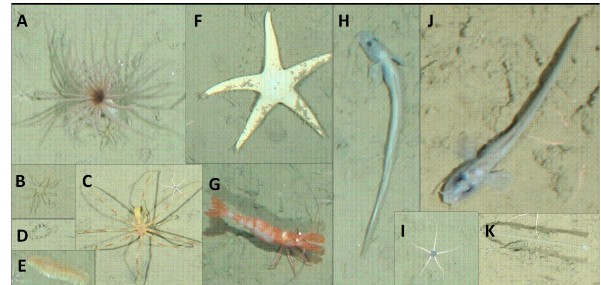
Fig. 2. Taxa found at station HG I. (A) purple cerianthid; (B) cf. Nymphon macronyx ; (C) Colossendeis proboscidea ; (D) Elpidia sp.; (E) Bylgides sp.; (F) Bathybiaster vexillifer ; (G) Bytho- caris cf. leucopis ; (H) Lycodonus flagellicauda ; (I) Ophiocten gra- cilis ; (J) Lycodes squamiventer ; (K) Jasmineira schaudinni . Scale bar = 10cm, (A–B) , (D–K) ; 5cm, (C) .